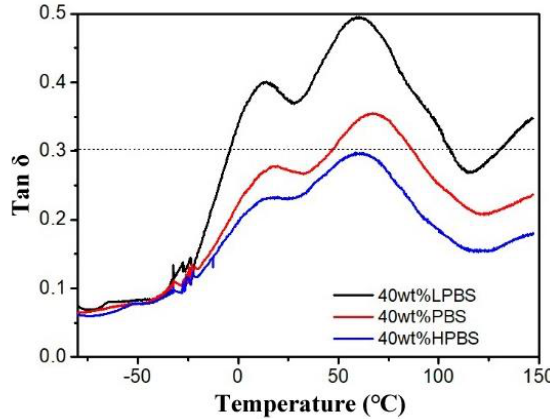
Figure 6. DMA curves of LPBS / PBS / HPBS-gel / MVQ composites tested at 1 Hz.